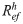
Estimation of Model PMAL in Period 2 (October/2000—September/2004).(a) observed incidence (O) and adjusted i (E), (b) m3/m, (c) Refh (h) and Refm (m), and (d) Ref=Refh×Refm.